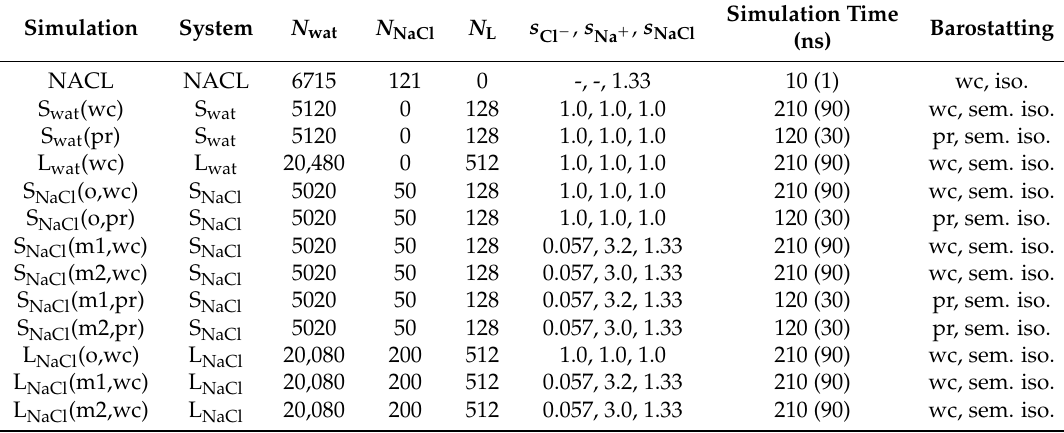
Table 7. Overview of the performed simulations. The first column provides an acronym for the different simulations, consisting of a label for the simulated system (NACL, S wat , S NaCl , L wat or L NaCl ; Section 4.1) and an indication of the employed force field (o, m1, m2) and barostatting (wc, pr). N wat and N NaCl denote the number of water molecules and cation-anion ion pairs, respectively; N L denotes the number of lipid molecules. The parameters s , s and s NaCl specify the scaling factors applied Na + Cl −